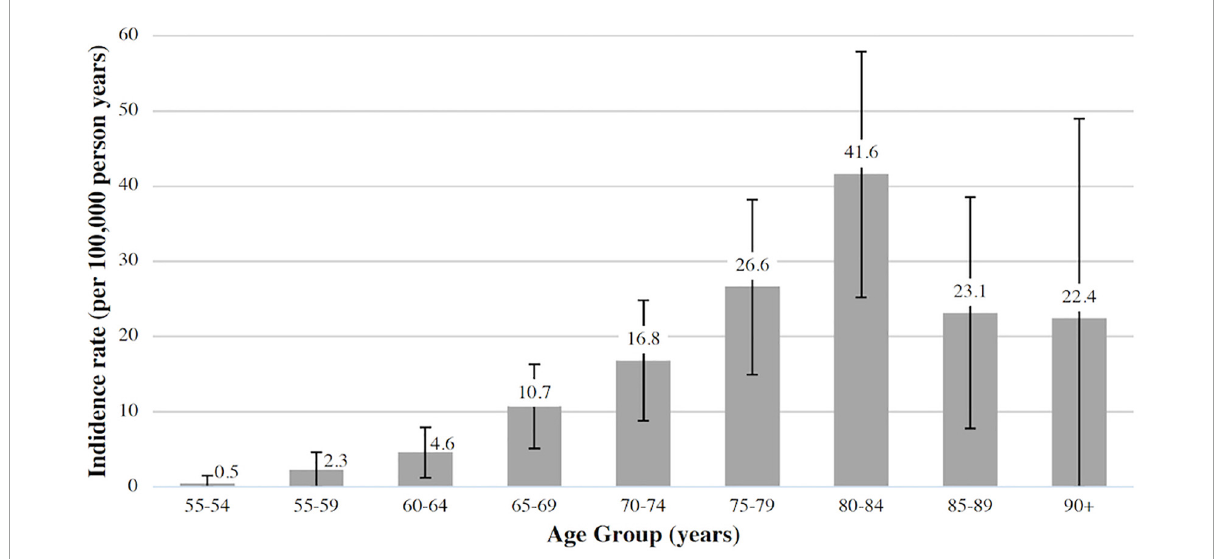
FIGURE1 Incidence of biopsy-proven giant cell arteritis (GCA) in Canterbury (adjusted for age and sex, 95% CI).